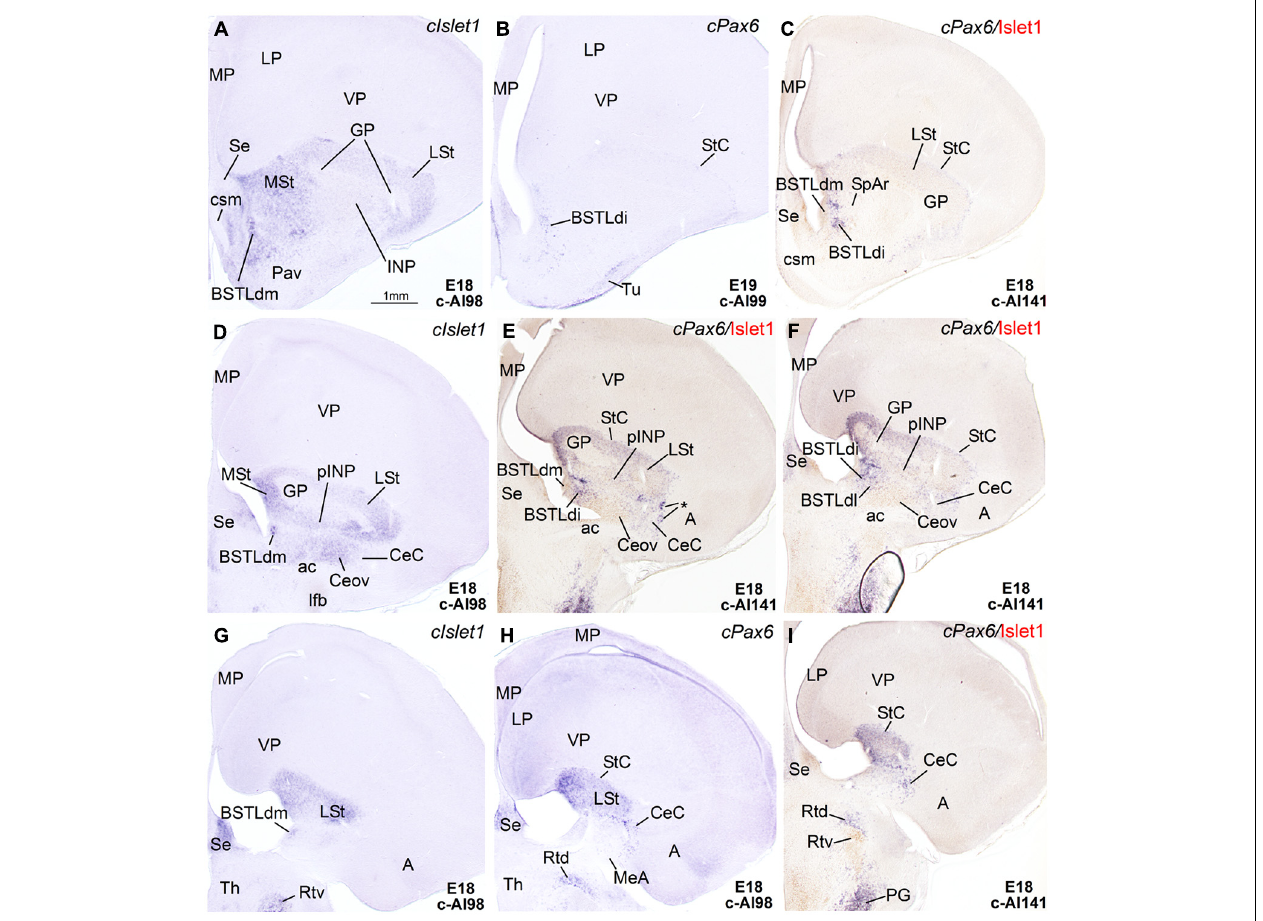
sections at the level of intermediate aspects of BSTLd, as well as the peri-INP island field (pINP), Ceov, and CeC; (G–I) are sections at caudal levels of the subpallium, where only the CeC and caudal parts of BSTLd remain present. Asterisk in (E) is showing a cPax6-expressing cell patches, intercalated at the border between CeC and the arcopallial amygdala (A). See text for more details. For abbreviations, see list. Scale bar: A = 1 mm (applies to A–I